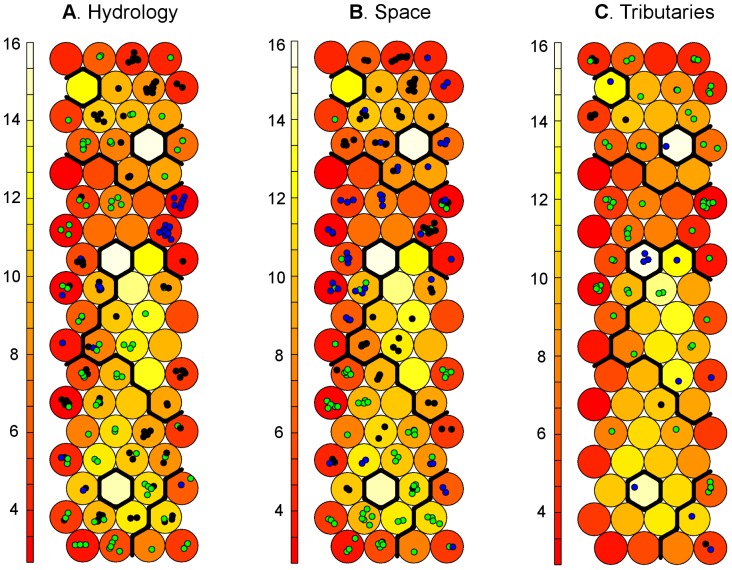
Projection of space, discharge, and type of tributary onto the U-matrix.Neuron colour scale indicates, for every neuron, the sum of the euclidean distances to all its immediate neighbours. Samples are projected on the SOM grid and coloured according to A) hydrology: blue represents flood conditions, black represents base flow, and green drought; B) space: blue corresponds to headwater samples, black middle reaches samples, and green are the lowland samples; C) types of tributary: blue are industrial, black are WWTP, and green are natural tributaries.